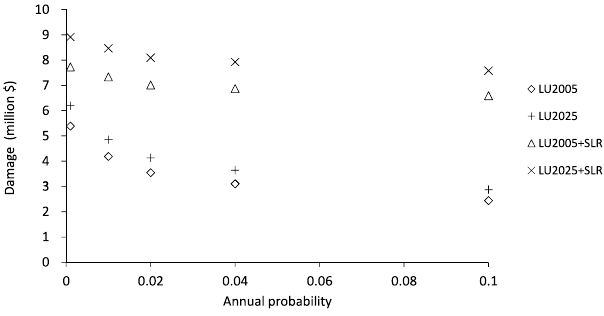
Figure 7. Annual probability and damage curves for different com- binations of land-use and sea-level